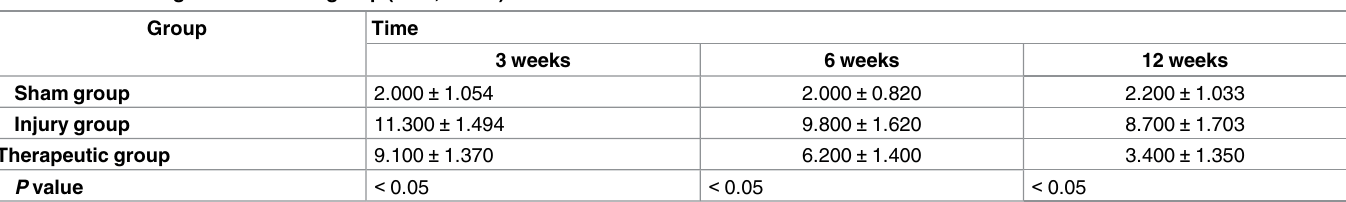
Table 1. HE staining score for each group (x ± s, n =